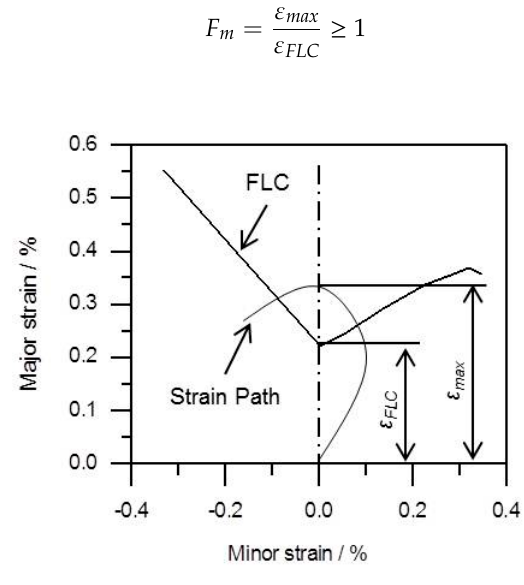
Figure 11. The Max Failure evaluation criteria of 6014-T4 sheet.